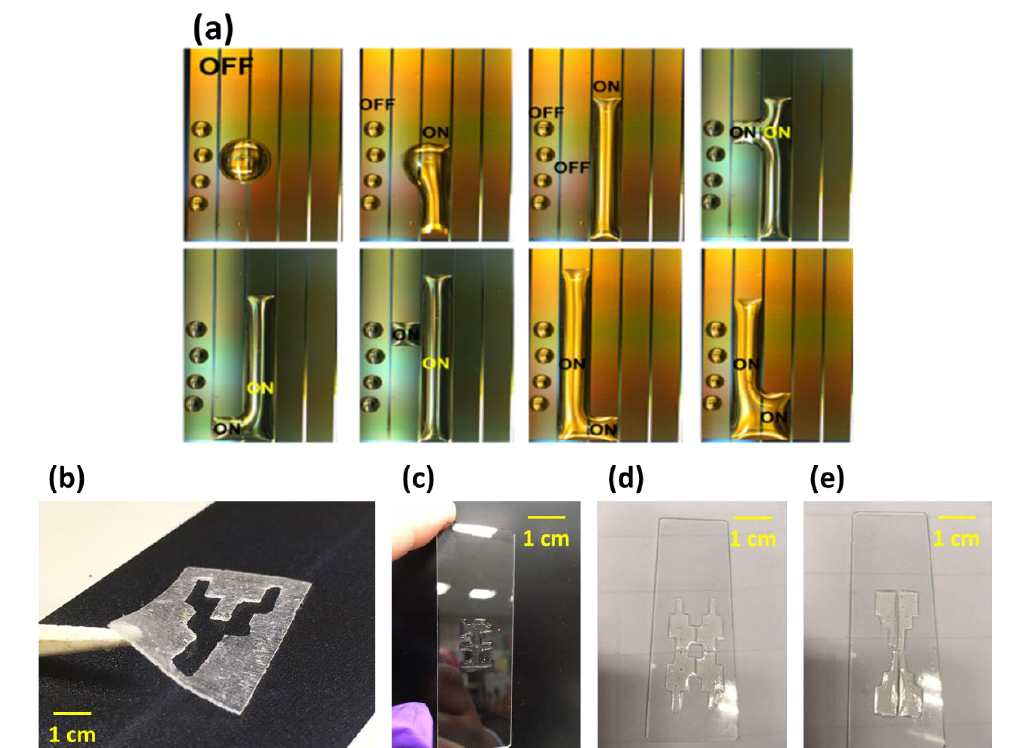
Figure 10. ( a ) UV resin patterning using a dielectric chip. ( b – e ) Different shape of structure fabri- cation using a dielectric system. The thickness of each structure was around 1~2 mm.